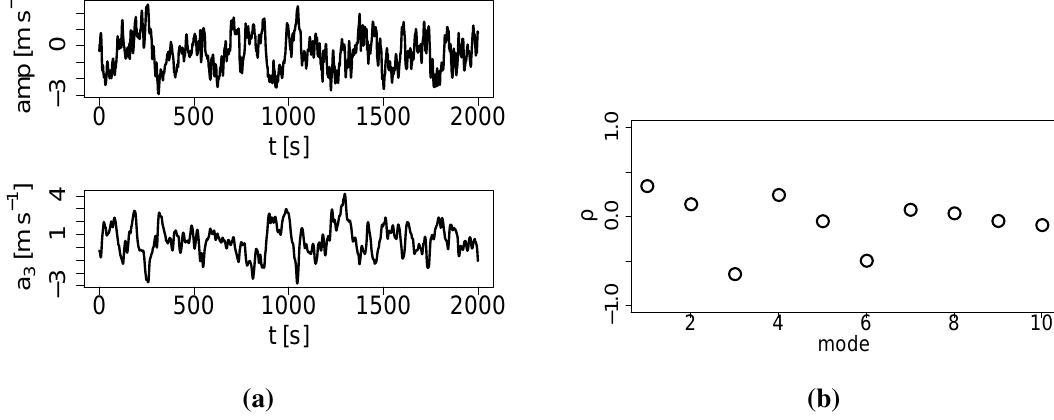
Figure 15. ( a ) Time series of the third weighting coefficient a the deficit (called amp in the figure); ( b ) correlation coefficients ρ of the average amplitude of the deficit with the weighting coefficients of the first 10